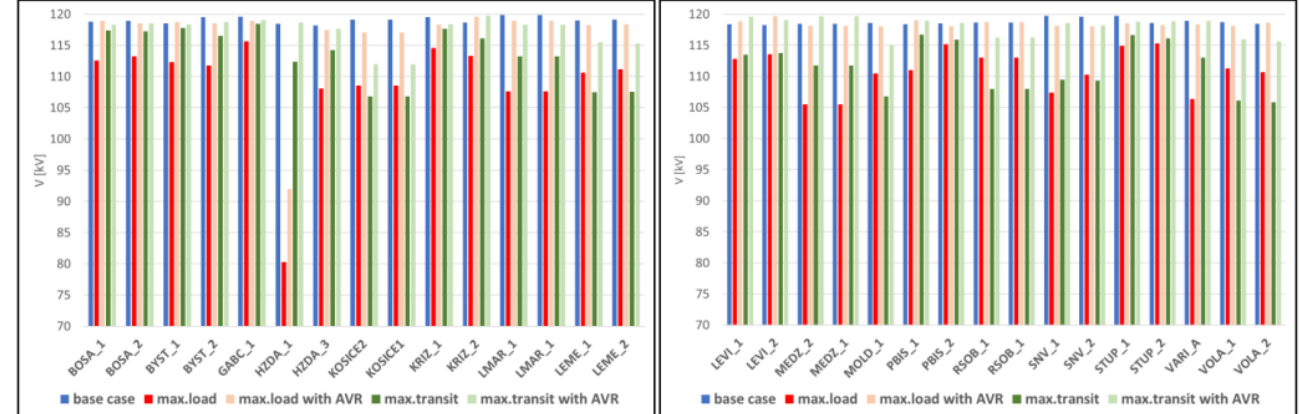
Figure 6. Voltage in 110 kV DS substations: winter.